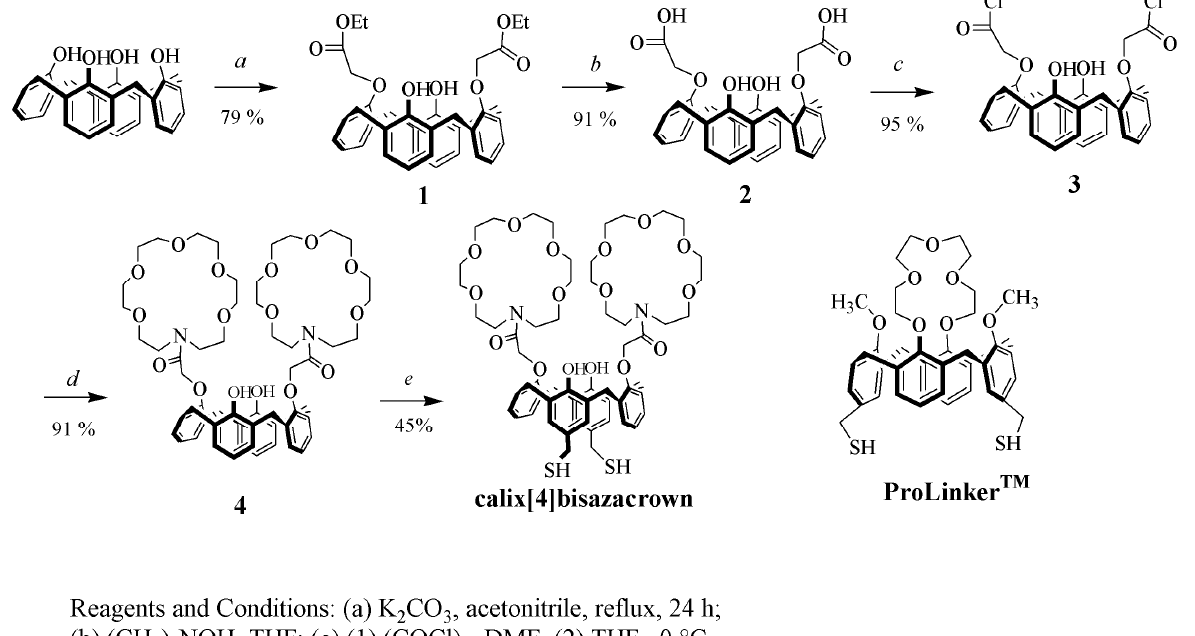
Figure 1 . Synthetic scheme of calix[4]bisazacrown and molecular structure of ProLinker TM